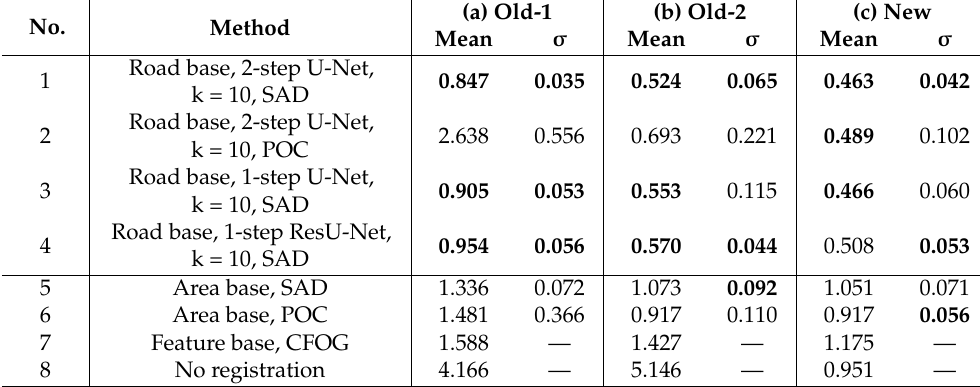
Table 5. Mean and standard deviation of RMSD of inter-GCP residuals with different methods applied (1–4: road-based methods based on proposed method; 5–6: area-based methods based on SAD and POC; 7: CFOG; 8: no registration) to (a) old-period aerial photo 1, (b) old-period aerial photo 2 and (c) new-period aerial photo as target images (unit: pixel). Three smallest values for each image are shown in bold.